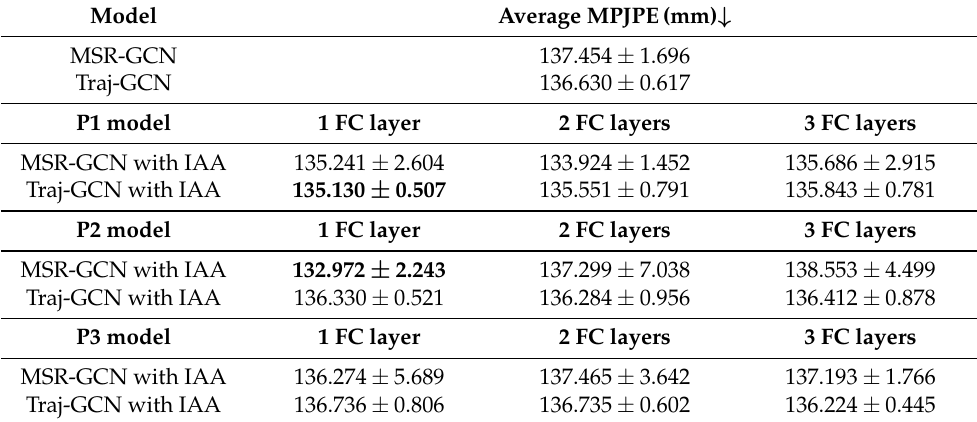
Table 3. Avarage MPJPE of 5 trials and its standard deviation on the PKU-MMD dataset. ↓ indicates that the smaller the value, the better. The bold indicates the best